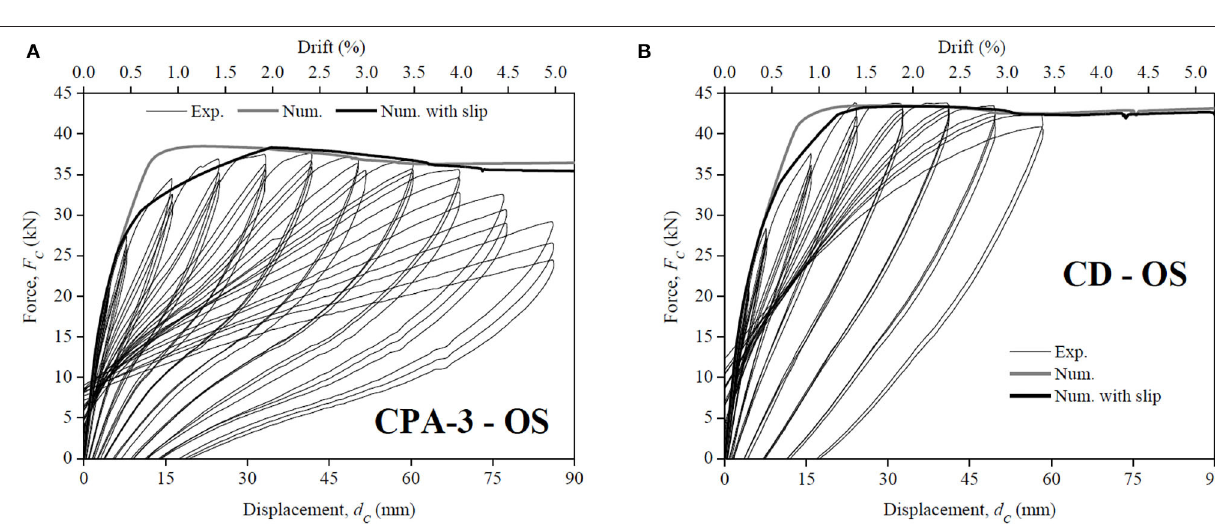
values proposed for β , α 1 , and α 2 in the previous section were adopted in this comparative